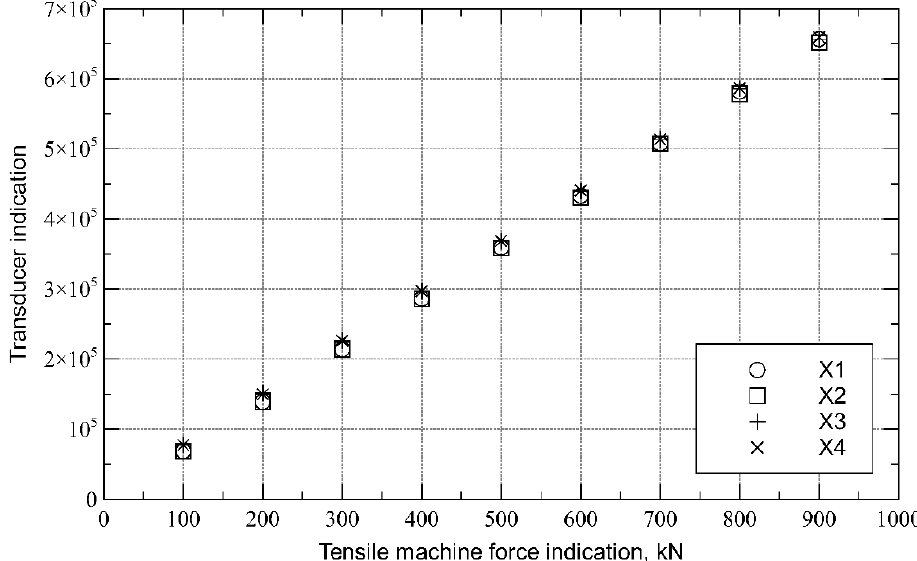
Figure 8. Results of device calibration.